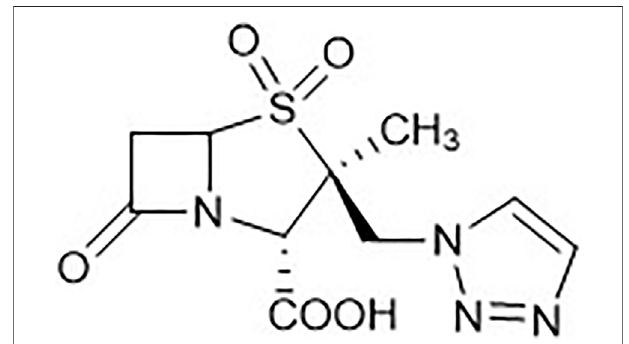
FIGURE 1 | Tazobactam (TazoH)